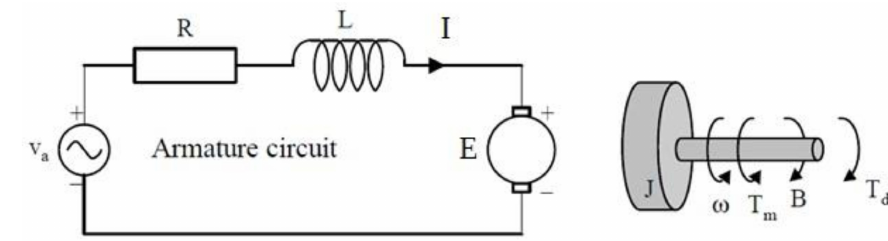
Figure 14. Equivalent circuit of the PMDC